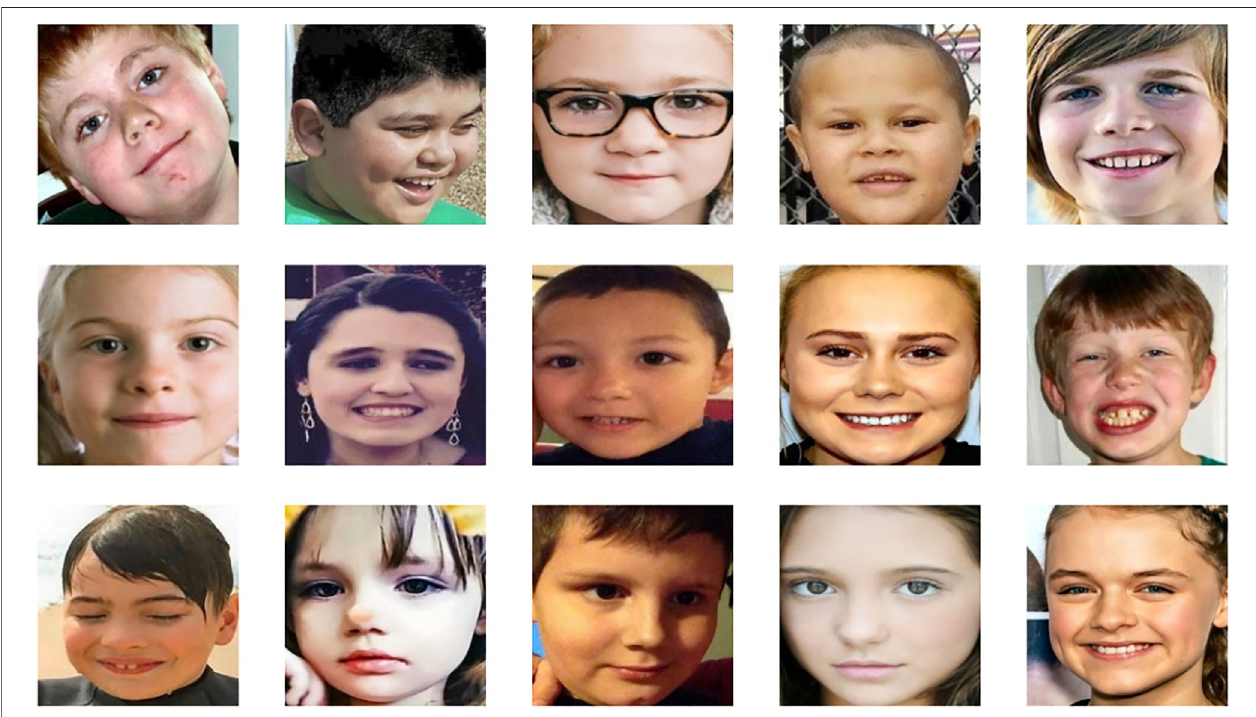
FIGURE 8 | Part of the images from the database. Detect Autism from a facial image (Guay et al., 2020).